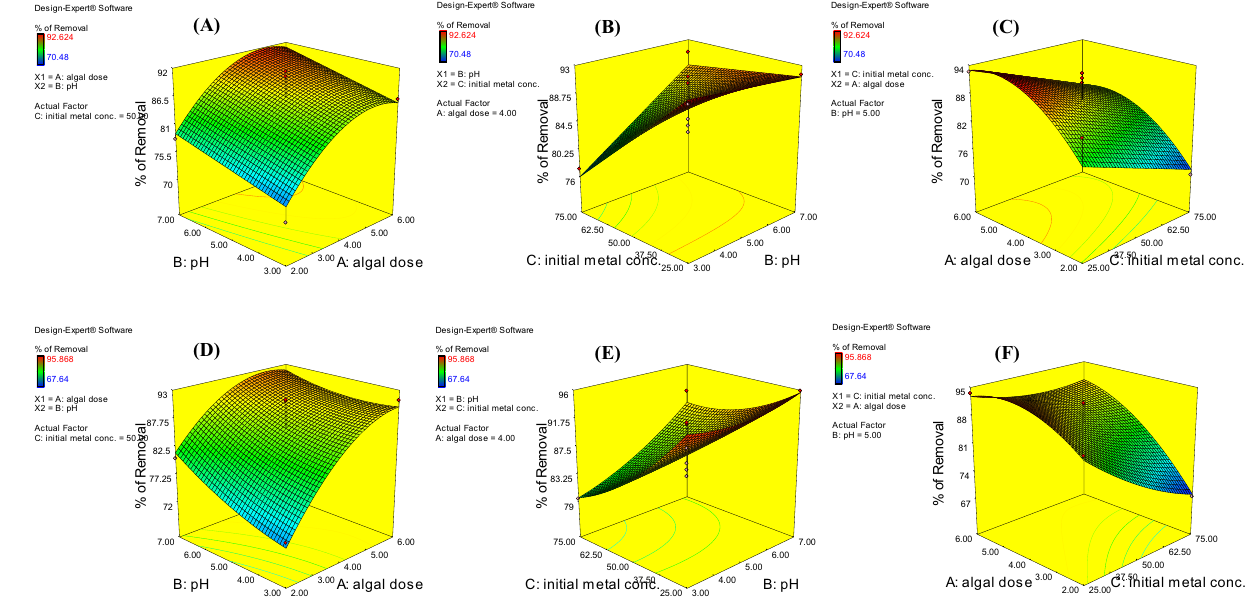
Figure 2. 3-D response surface plots of Cd 2+ ion biosorption using the freely suspended ( A – C ) and immobilized algal biomasses ( D – F ) under constant conditions: temperature 25 °C; time 90 min; shaking at 170